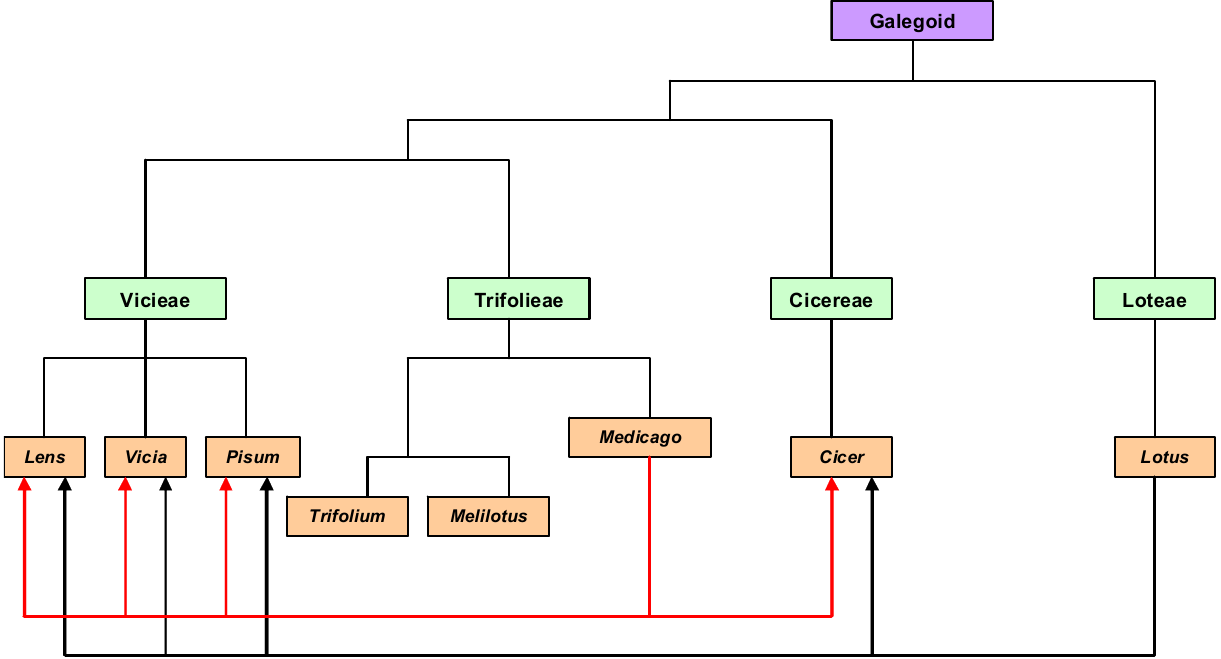
Figure 1. Taxonomic relationship between model and cool season food legumes (Arrows indicate the possibility of adaptation of information derived from model species (Mt, Lj) across cool season food legumes- translational genomics); Figure adopted from